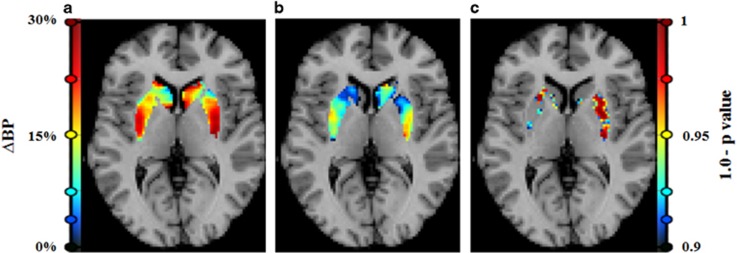
Images created from SRTM modeling at the voxel level. Analyses were performed on images aligned to a common space and averaged: (a) mean ΔBPMP+LPS image, (b) mean ΔBPMP+PBO image and (c) significance image created by paired t-testing ΔBP between drug conditions at each voxel. Voxel intensity is calculated as (1.0−P-value). Voxel values are only displayed where (1.0−P-value)>0.90. In this two-tailed t-test, no voxels were found to be significant for ΔBPMP+LPS<ΔBPMP+PBO. The sparsity of significant differences on the left side of the brain is likely due to greater observed variability in the MP+PBO condition in left ROIs (see Table 1 for ROI level values). BP, binding potential; LPS, lipopolysaccharide; MP, methylphenidate; PBO, placebo; SRTM, simplified reference tissue model.